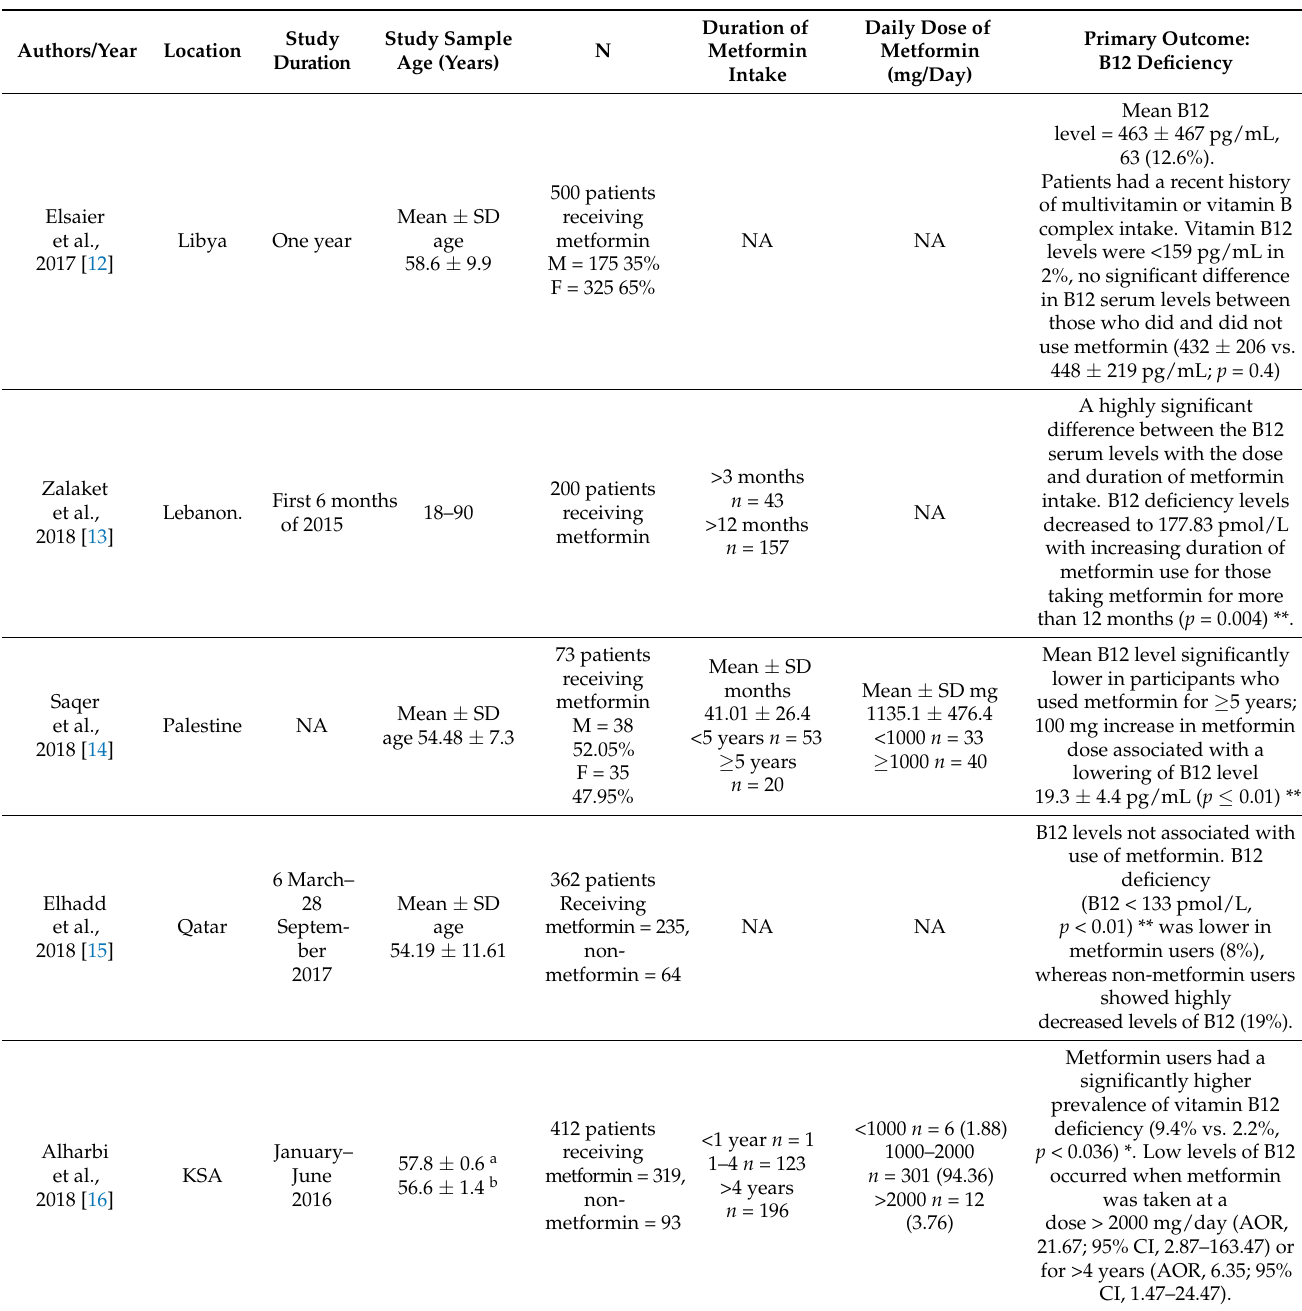
Table 1. Summary of studies included in this